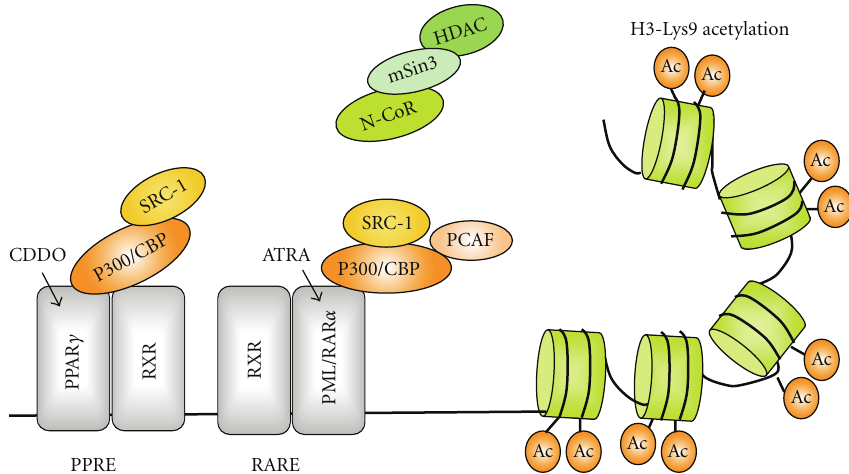
Figure 2: CDDO augments ATRA-induced reactivation of RAR β 2 in APL via histone acetylation. Combination of all-trans RA (ATRA) and 2-cyano-3,12-dioxooleana-1,9-dien-28-oic acid (CDDO) increases H3-Lys9 acetylation in RAR β P2 and RAR β 2 transcription. CDDO- bound PPAR γ may recruit coactivator proteins, including CBP-p300 and SRC-1 to PPAR γ /RXR, which in turn induce histone acetylation and reactivation of ATRA target genes. Ac: acetylated histone H3-Lys9, HDAC: histone deacetylase, mSin3: mammalian homolog of the S. cerevisiae corepressor, Sin 3, NCoR: nuclear receptor corepressor, SRC-1: steroid receptor coactivator-1, CBP/p300: CCAAT/enhancer- binding protein, PCAF: P300/CBP-associated